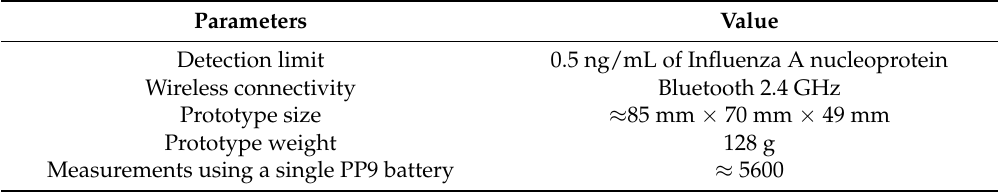
Table 2. Features and performance of the reader device